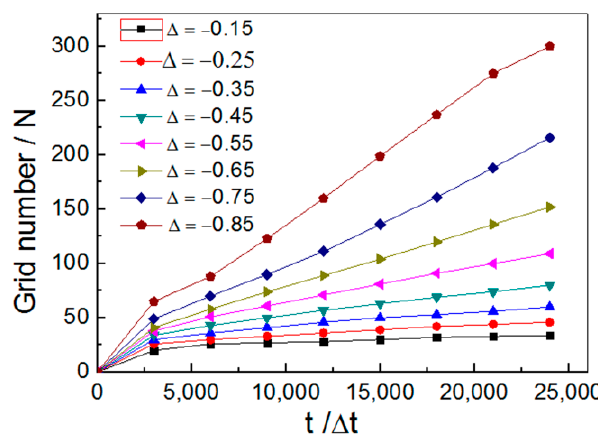
Figure 4. The tip grid positions of crystals at different degrees of supercooling. When ∆ = − 0.45, λ = 6.359. The grain morphology of the anisotropy coefficient changed sequentially. The growth rate of the crystal tip increases under the conditions of different anisotropy coefficients as the anisotropy coefficient increases (Figure 5). The tip of each crystal is relatively round when the anisotropy coefficient is 0.03~0.05, but the growth rate of the tip is not very different. The main branch end of the dendrite becomes sharper when the anisotropy coefficient is 0.06 and the growth rate increases. Edges and corners appear on the interface when the anisotropy reaches 0.07. The dendrite is no longer smooth, and the morphology changes. The dendrite bifurcates, and the needle-like dendrites parallel to each other appear at the main branch end. The root appears to have an obvious necking phenomenon accompanied by two secondary dendrites. The crystal morphology changes from a non-facet crystal to a facet crystal. The secondary dendrites become more developed when the anisotropy is greater than 0.07. High-order dendrites appear, and the crystal growth rate increases with a more vertical growth direction. The growth rate lowers in the dendrite trunk.